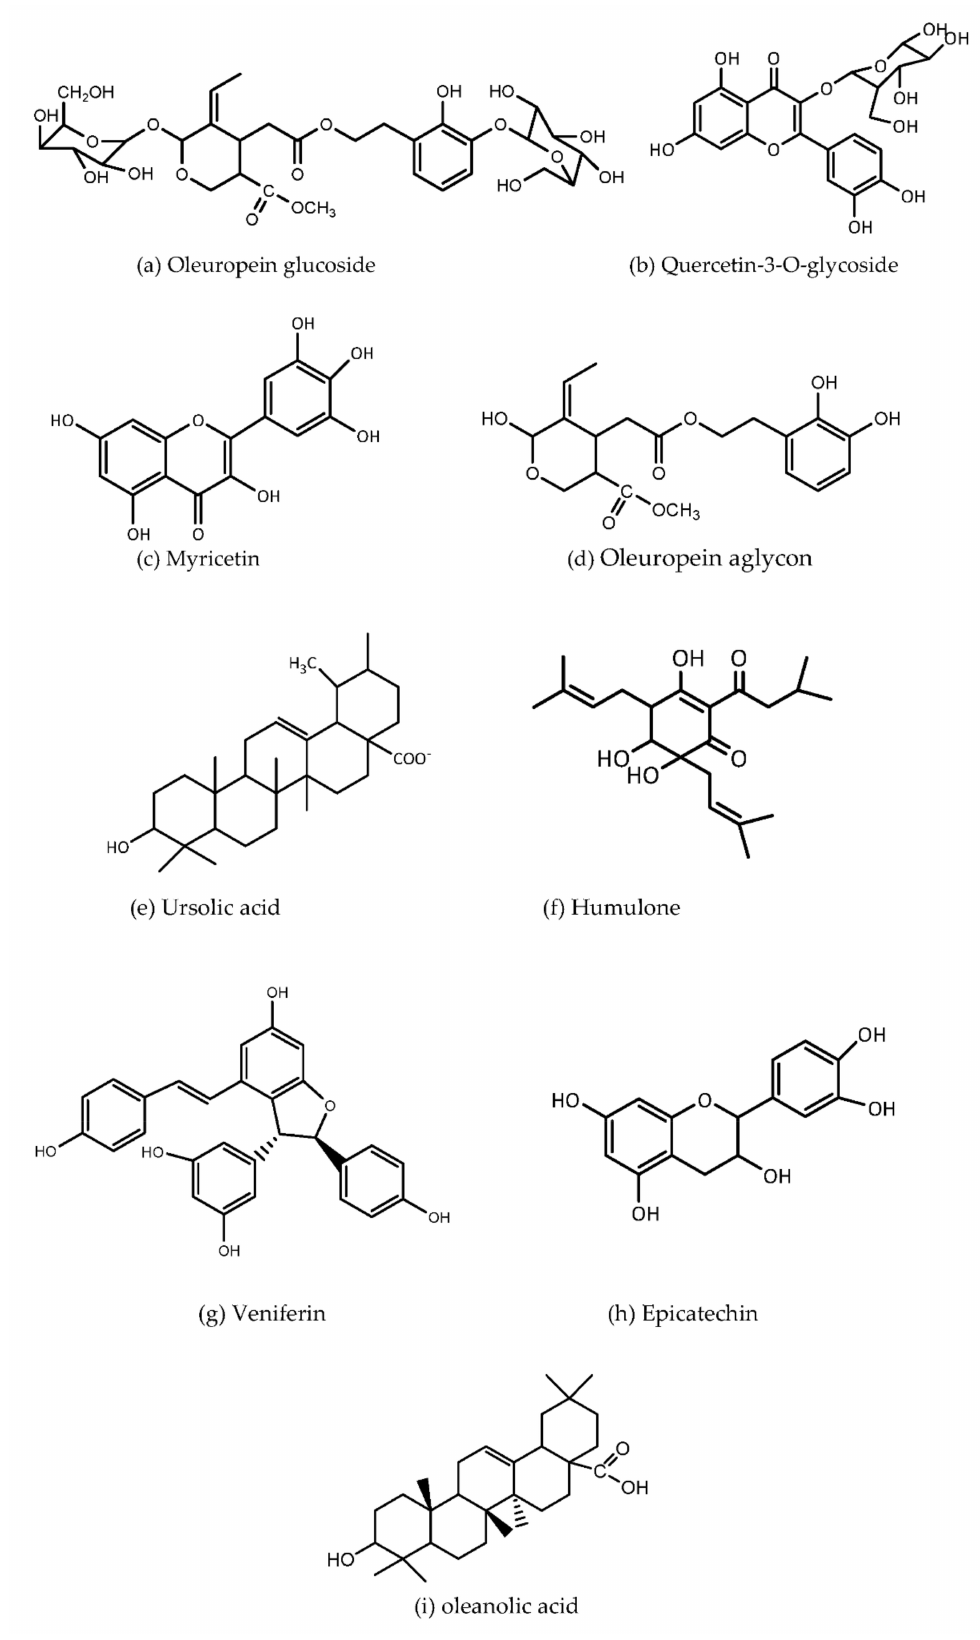
Figure 3. Molecular structure of the nonpolar fraction of Lantana camara